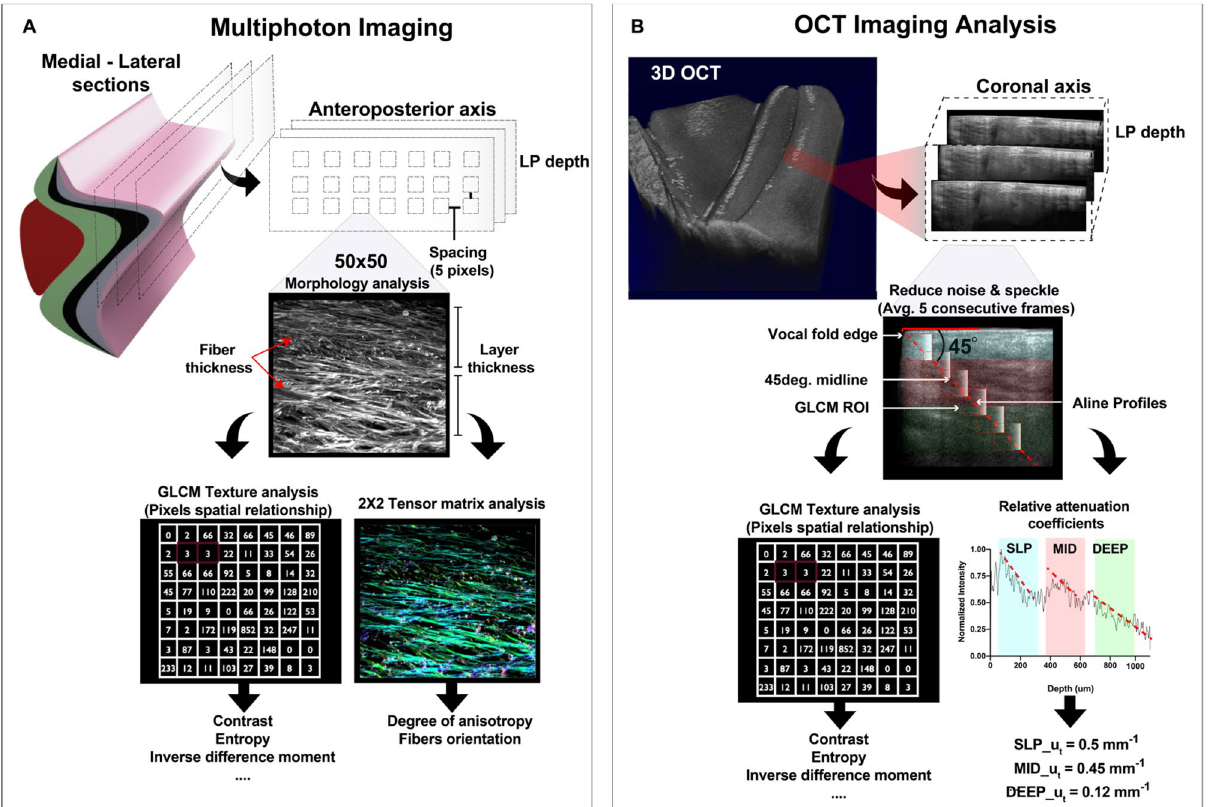
Figure 3. Multiphoton and OCT quantitative analysis. The anteroposterior sagittal sections were divided into multiple 50 × 50 × 50 pixels windows. Each window representing a position in the lamina propria (LP) was processed through a gray-level co-occurrence matrix (GLCM) and a structure tensor (A) . Features extracted are the collagen and elastic fiber diameters, the degree of anisotropy, fiber principal orientation, and second- order statistics. OCT images were averaged to improve the signal to noise ratio prior to the texture and relative attenuation analysis (B)